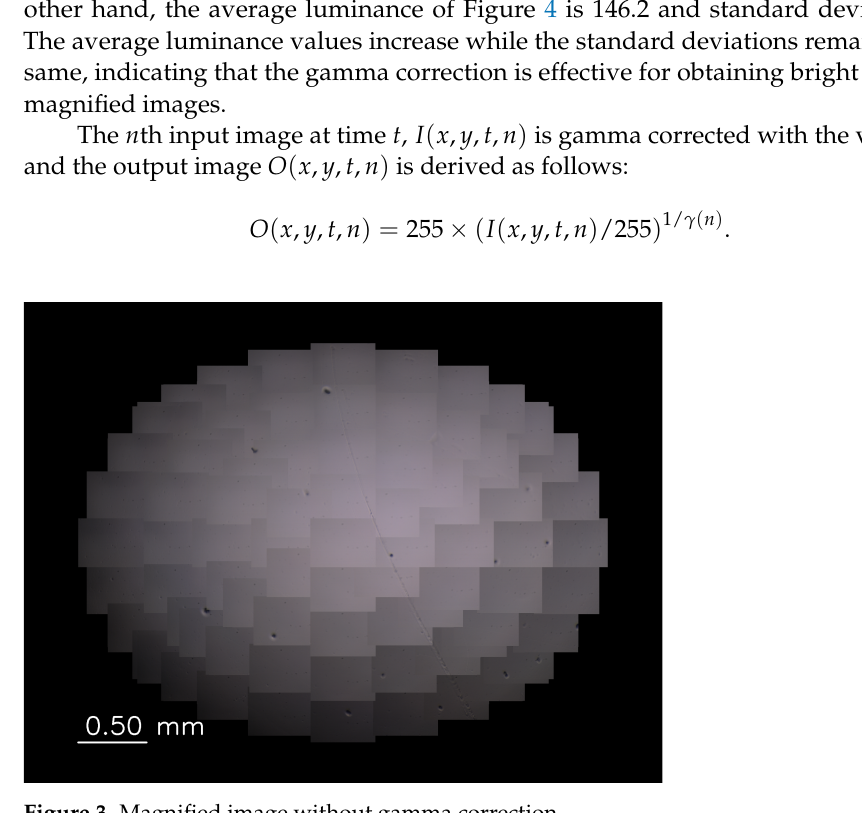
Figure 3. Magnified image without gamma correction.